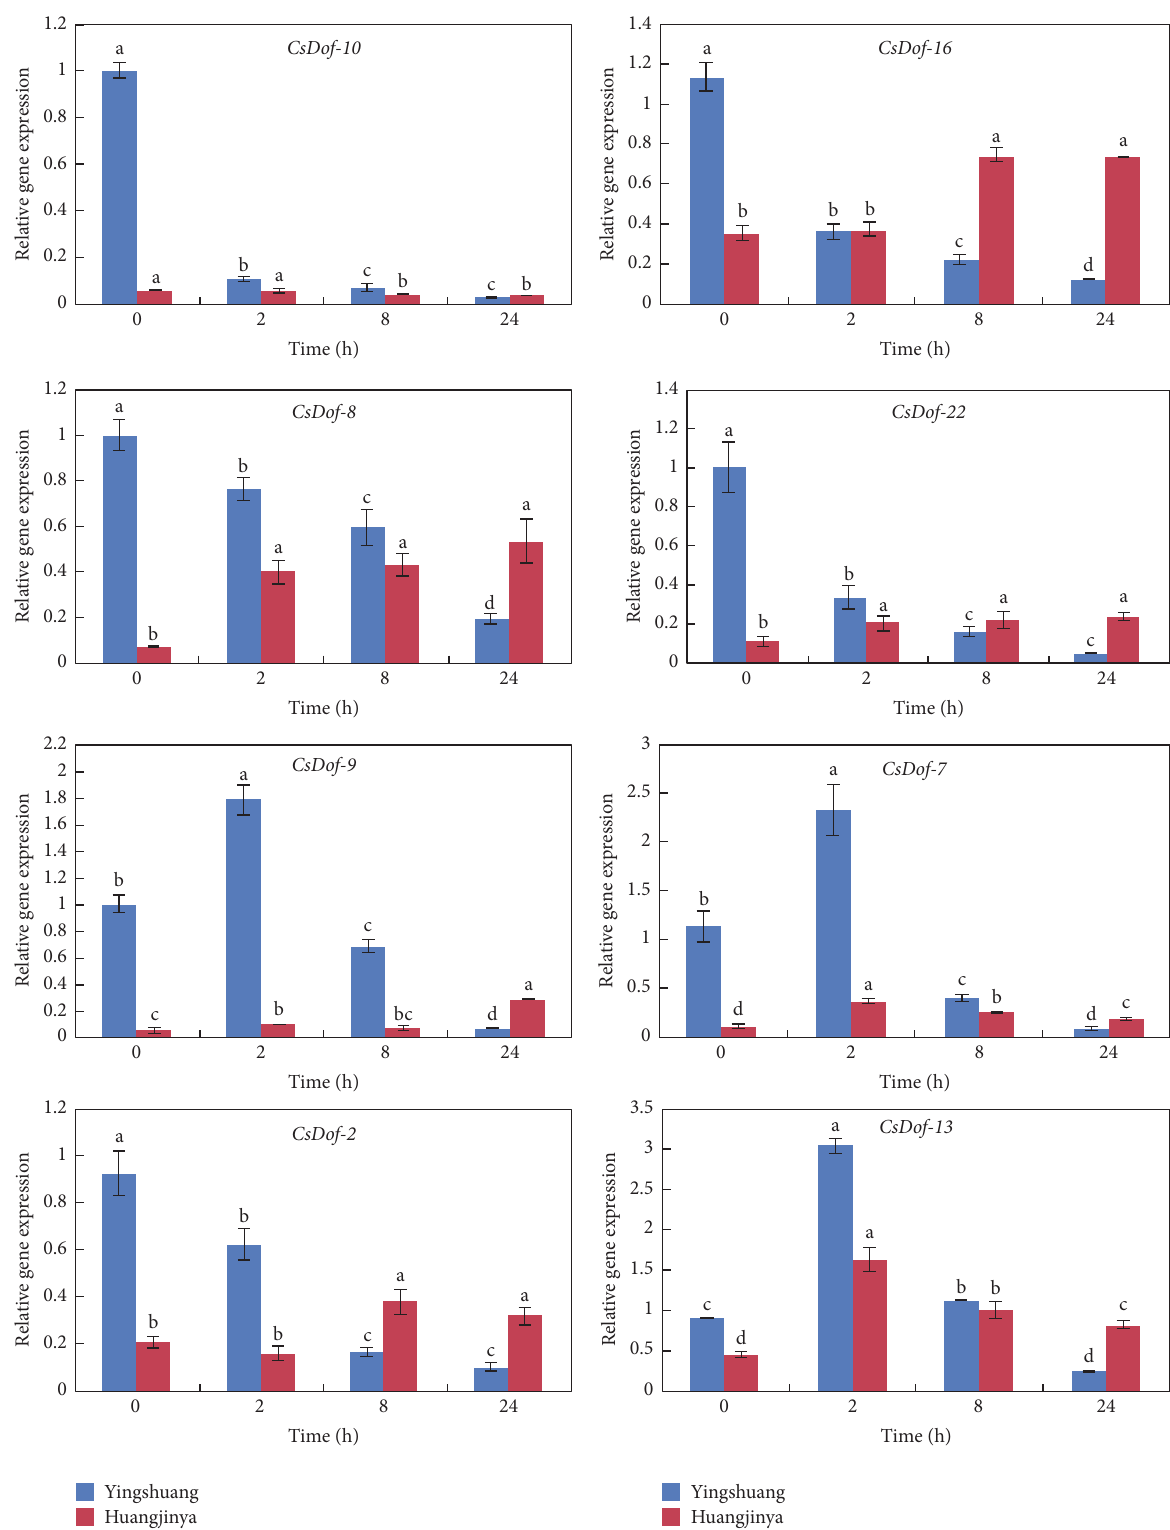
Figure 10: Expression patterns of CsDof genes in “Yingshuang” and “Huangjinya” under cold temperature stress. Error bars represent standard deviation among three real-time quantitative PCR reaction replicates. Data are means of three technical replicates ± SD. Different lowercase letters indicate significant differences at 𝑃 < 0.05